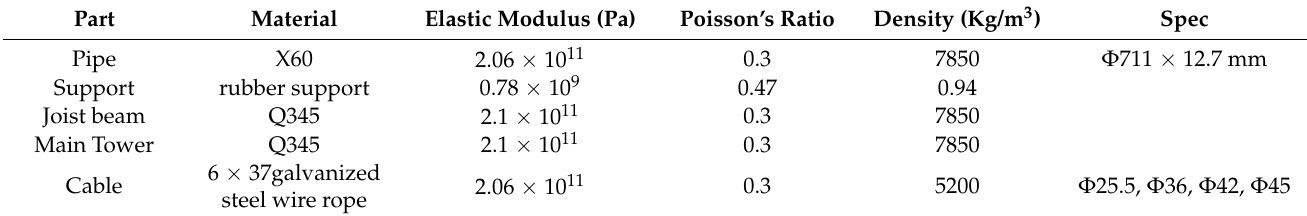
Table 1. Parameters of the cable-stayed pipe